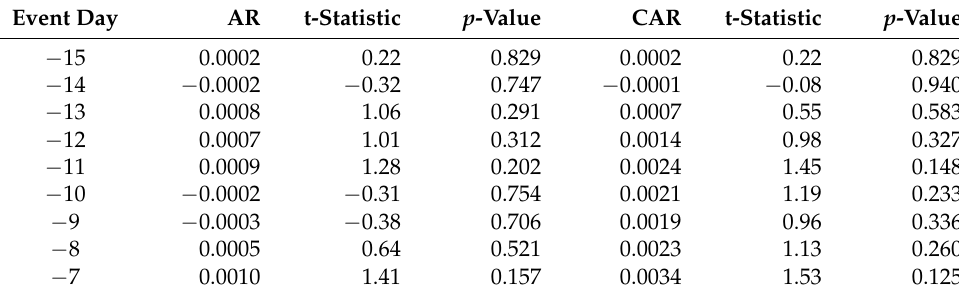
Table A1. Abnormal-return statistics for good